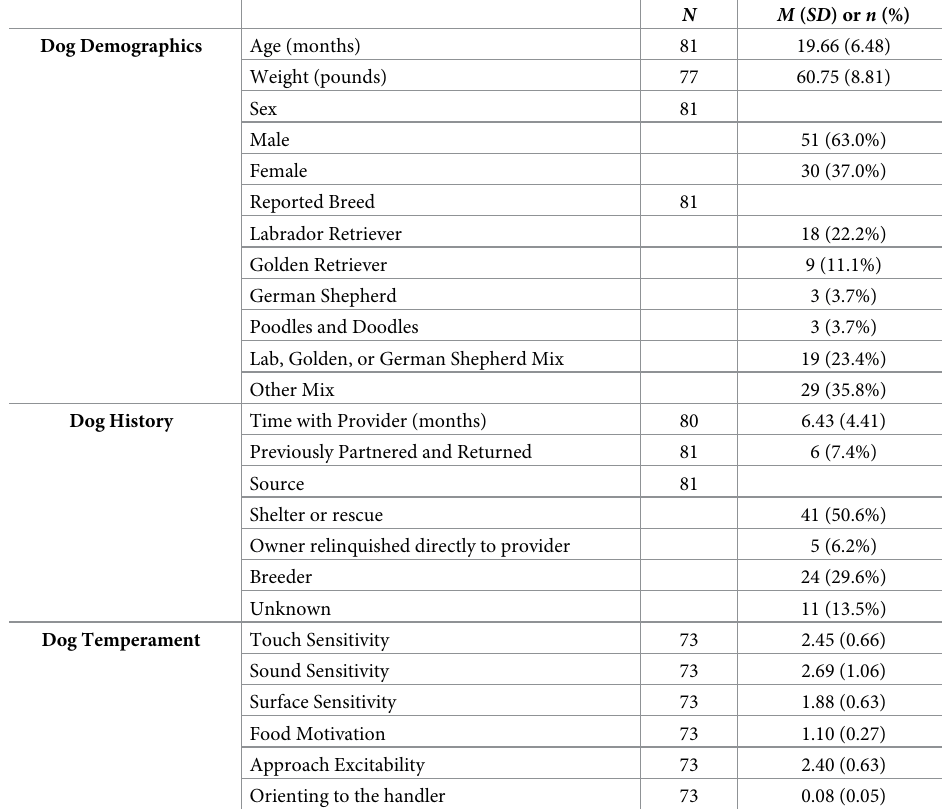
Table 3. Service dog demographic characteristics and